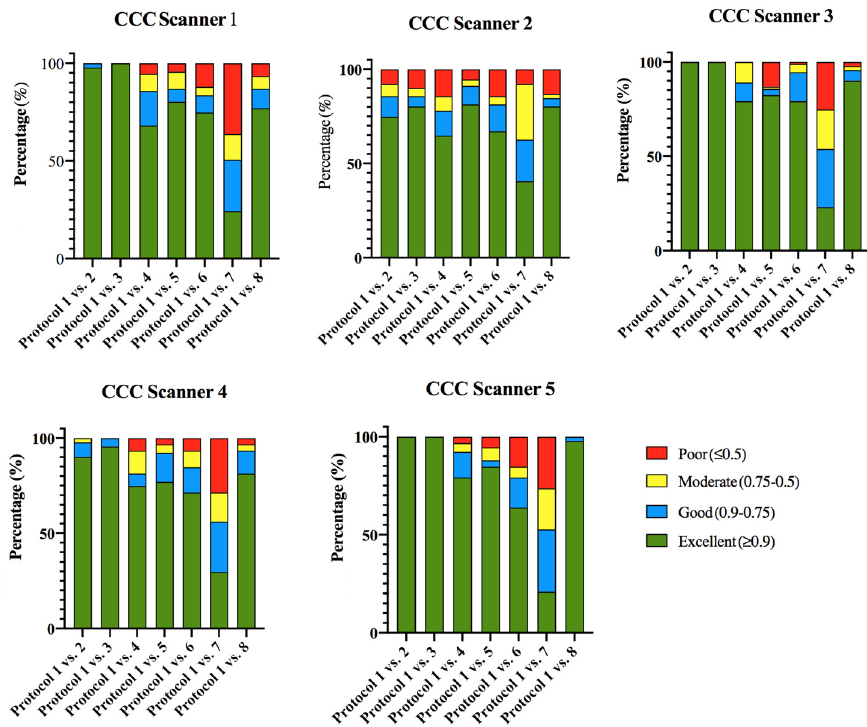
Figure 3. Histograms representing the percentage of features according to their CCC value for the five CT scanners when changing some parameters from protocol 1.